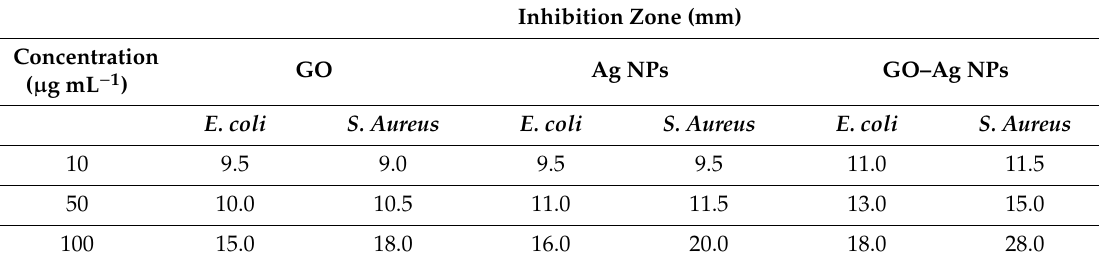
Figure 5. Digital images of antibacterial activity using disk diffusion assay for control, GO, Ag NPs, and GO–Ag NPs toward E. coli ( a ) and S. Aureus ( b ) after treatment with nanomaterials. From left to right, the concentrations were gradually increased from 10, 50, to 100 µg mL −1 , respectively. Table 2. Disc di ff usion inhibition zones for S. Aureus and E.